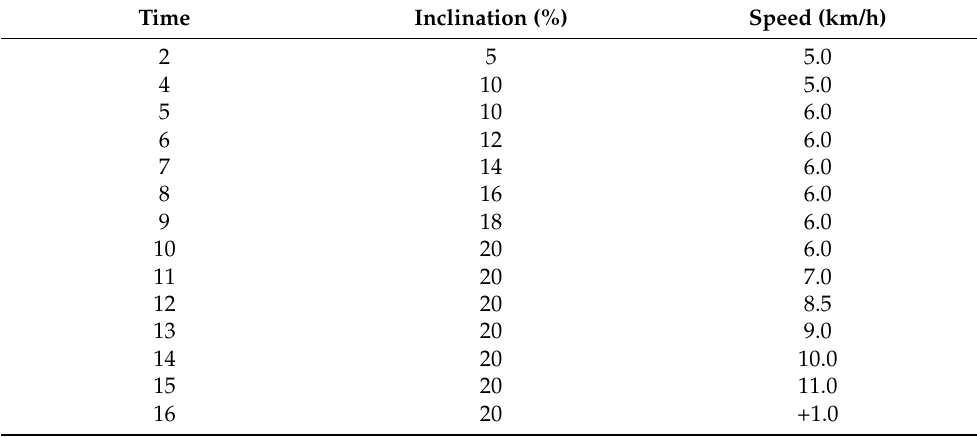
Table 2. Schematic of the uphill running protocol.